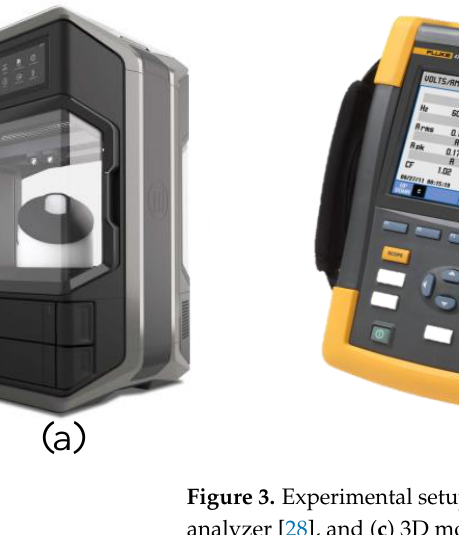
Figure 4. Experimental power vs. time graph in the RUN 1.